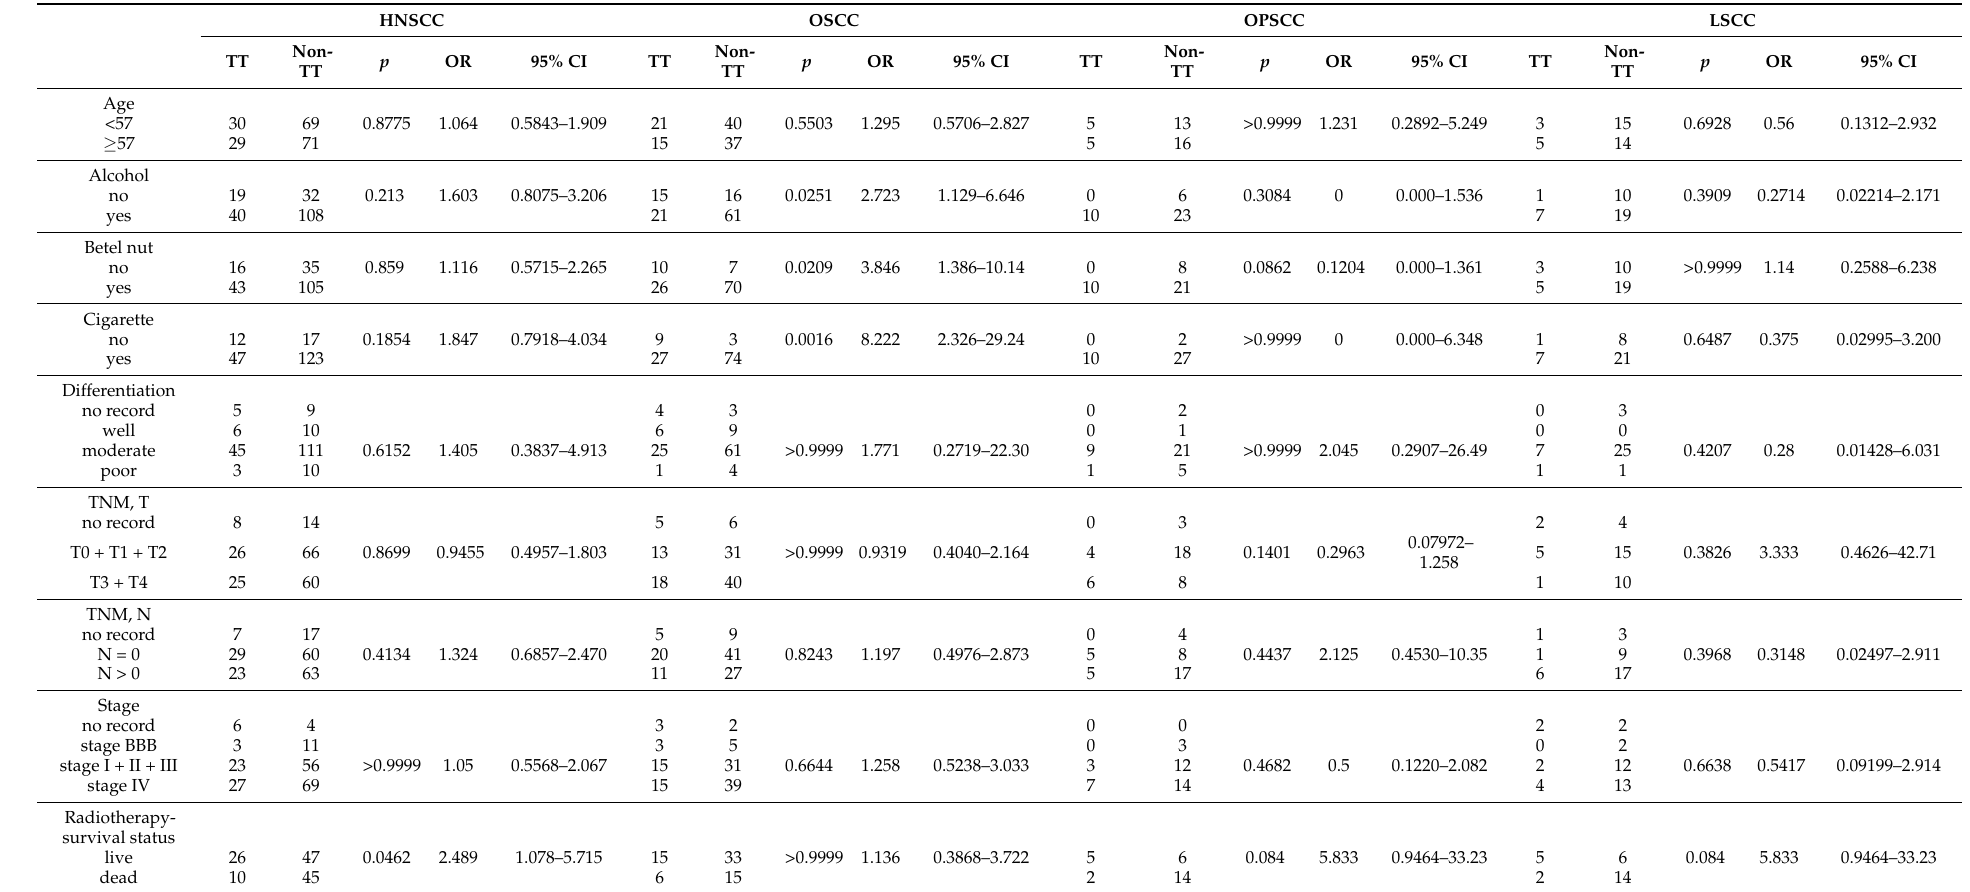
Table 1. Comparison of clinical parameters between GALNT14 -rs9679162 TT and non-TT genotypes in